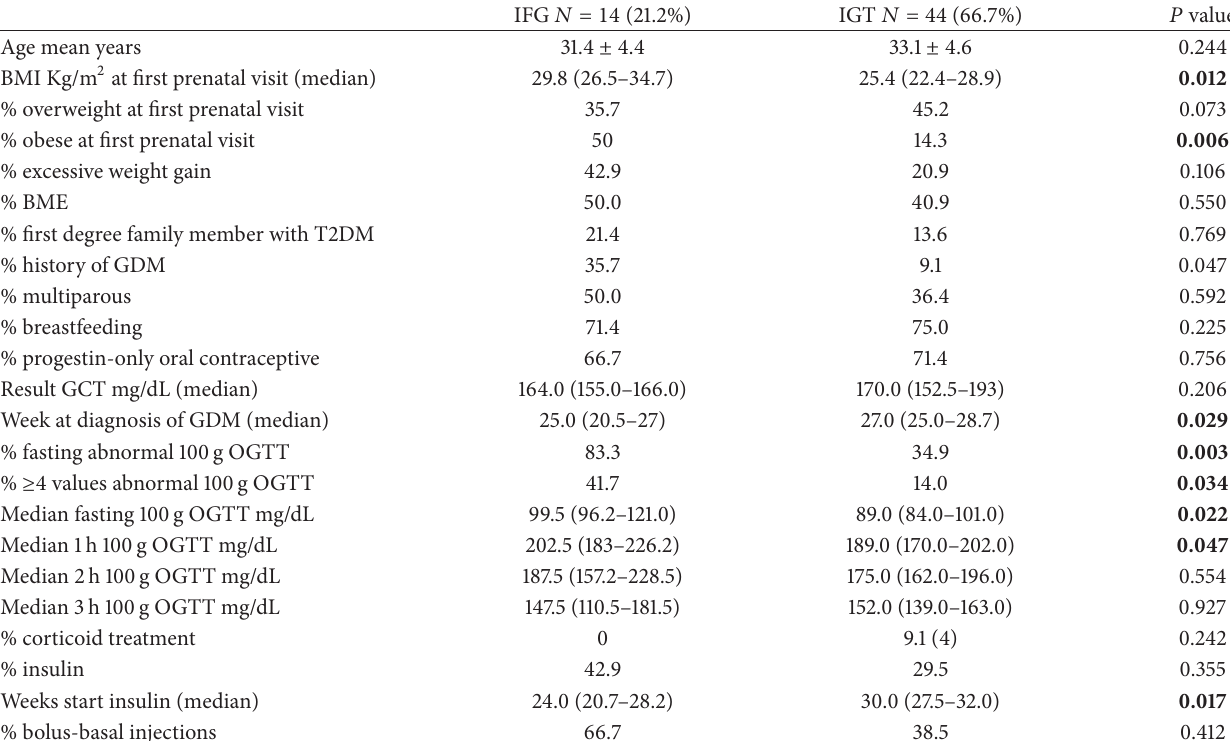
Table 4: Comparison of characteristics between women with an impaired fasting glucose (IFG) and women with an impaired glucose tolerance (IGT) postpartum.